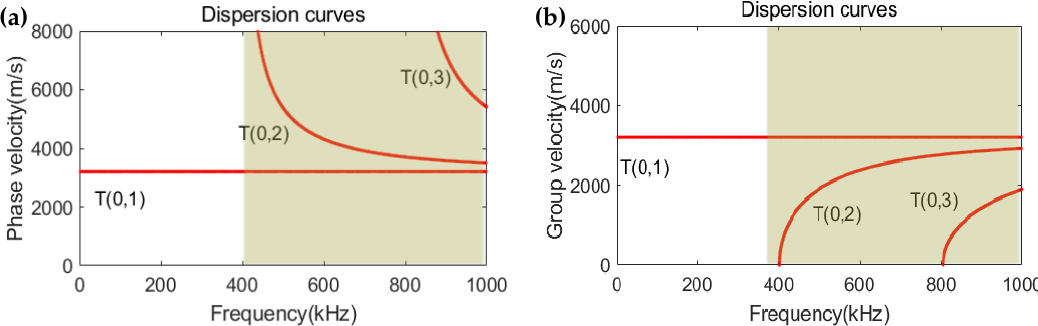
Figure 12. Dispersion curves of pipes illustrated in Table 1: ( a ) phase velocity curves; ( b ) group velocity curves.